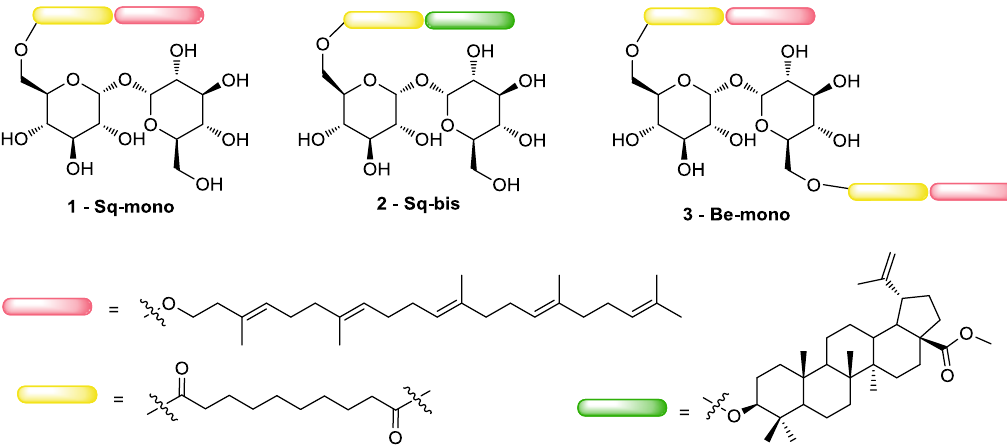
Figure 1. Chemical structure of nanolipid-trehalose conjugates 1-Sq-mono , 2-Sq-bis , and 3-Be-mono .